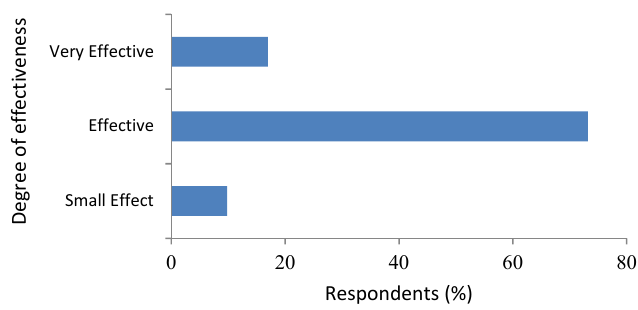
Fig. 6: Perceived effectiveness of pesticide application